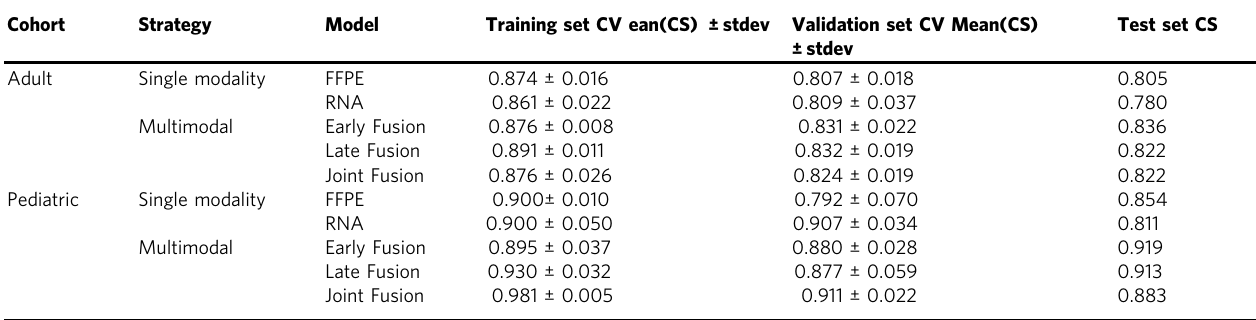
Table 1 Composite Scores (CS) of survival predictions on adult and pediatric glioma cohorts using two single modality models (FFPE & RNA), and three data fusion methods (early, late &